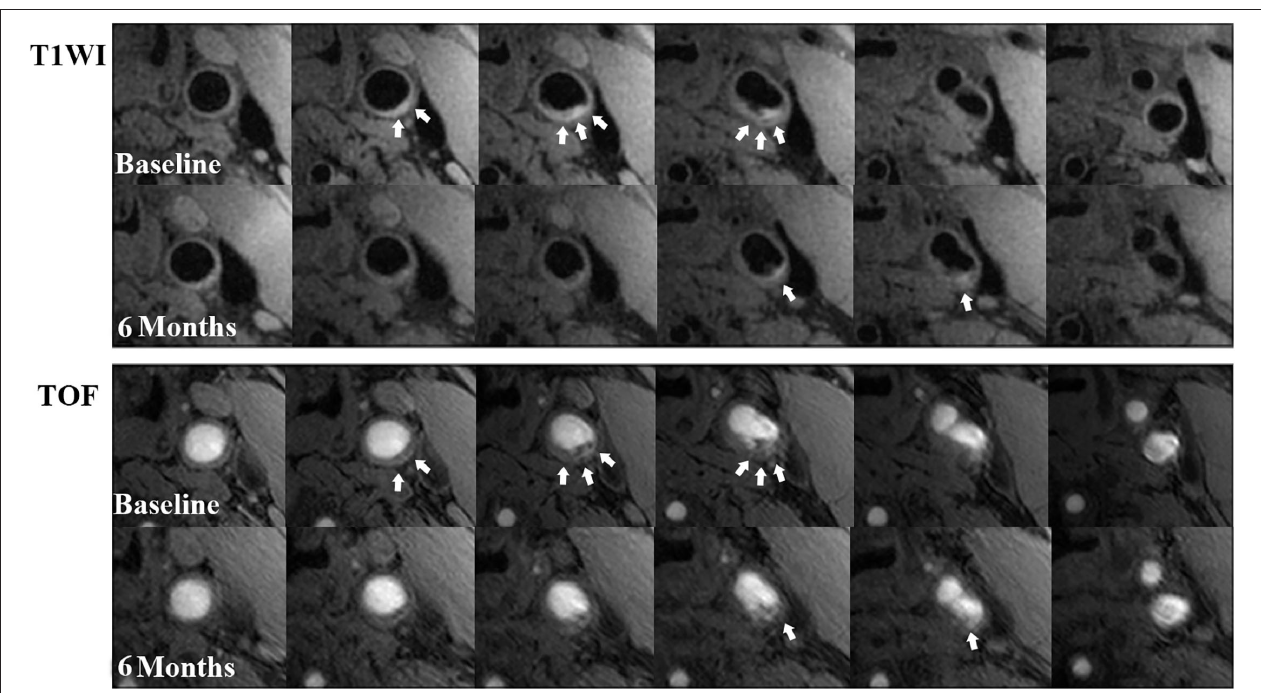
FIGURE 3 | Examples of IPH regression during a 6-month follow-up. There is a remarkable regression in IPH volume (white arrows) at left carotid common artery with atherosclerosis on T1W (above 2 rows) and TOF (below 2 rows) images from the baseline to the follow-up. On some slices of the follow-up MR images, the hyperintense signal (IPH) disappeared compared with those at